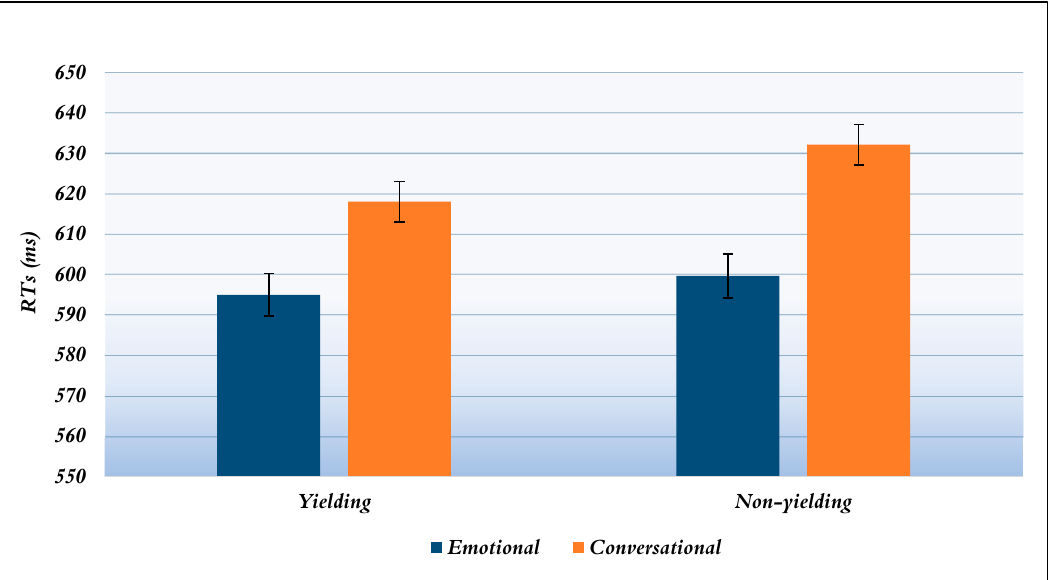
Figure 2. Mean RTs for crossing intention in the presence of yielding and non-yielding AVs for emotional and conversational facial expressions. Error bars represent standard error.